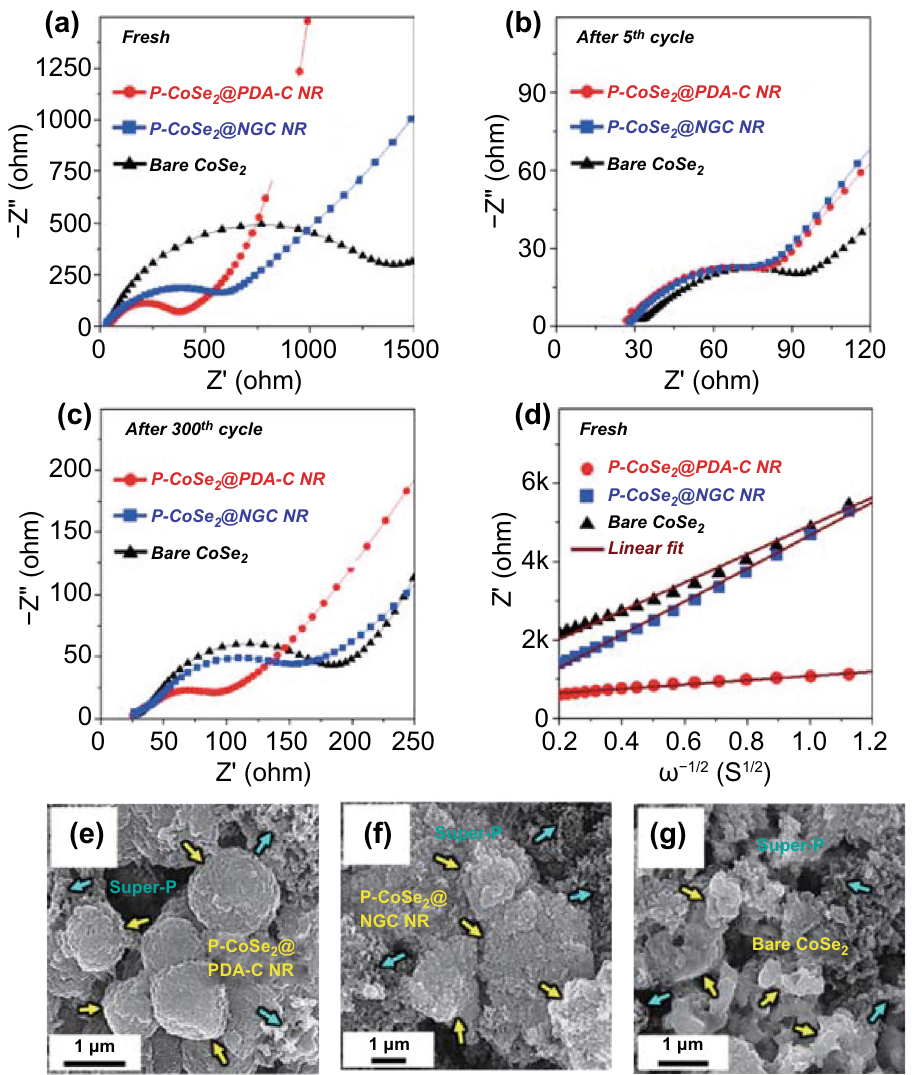
Fig. 7 a – d Nyquist impedance plots and e – g FE-SEM images of the P-CoSe 2 @PDA-C NR, P-CoSe 2 @NGC NR, bare CoSe 2 hollow micro- spheres obtained after 300th cycles at 0.5 A g −1 : a before cycling, b after 5th cycle, c after 300th cycle, d relationships between the real part of the impedance (Z re ) and ω −1/2 of the samples before cycling, e the P-CoSe 2 @PDA-C NR, f P-CoSe 2 @NGC NR, and g bare CoSe 2 hollow